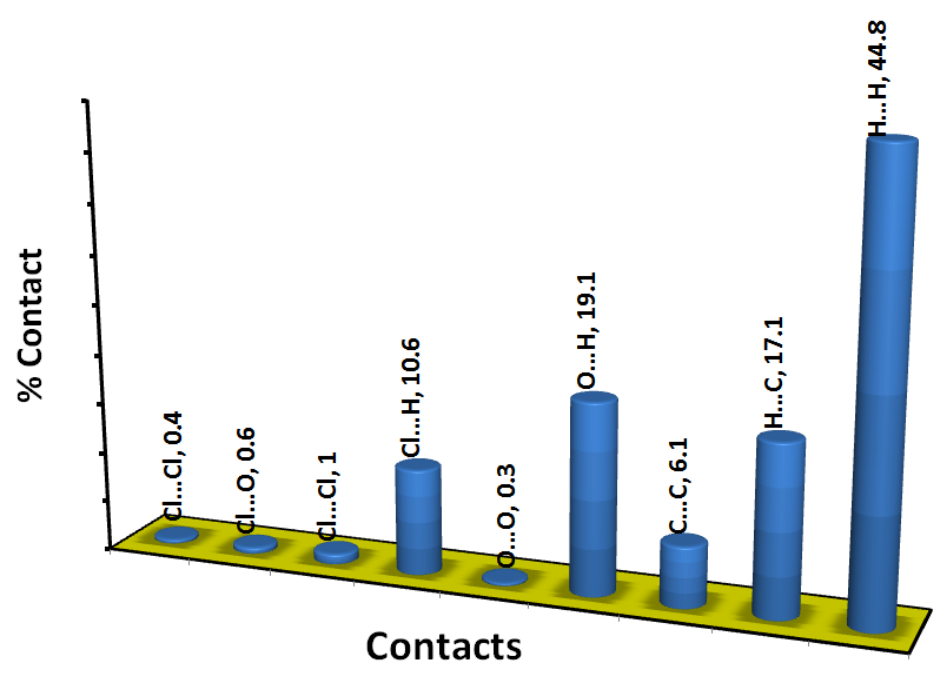
Figure 4. Intermolecular interactions in 3 . Table 4. Shortest intermolecular interactions and their distances. Contact Distance Contact